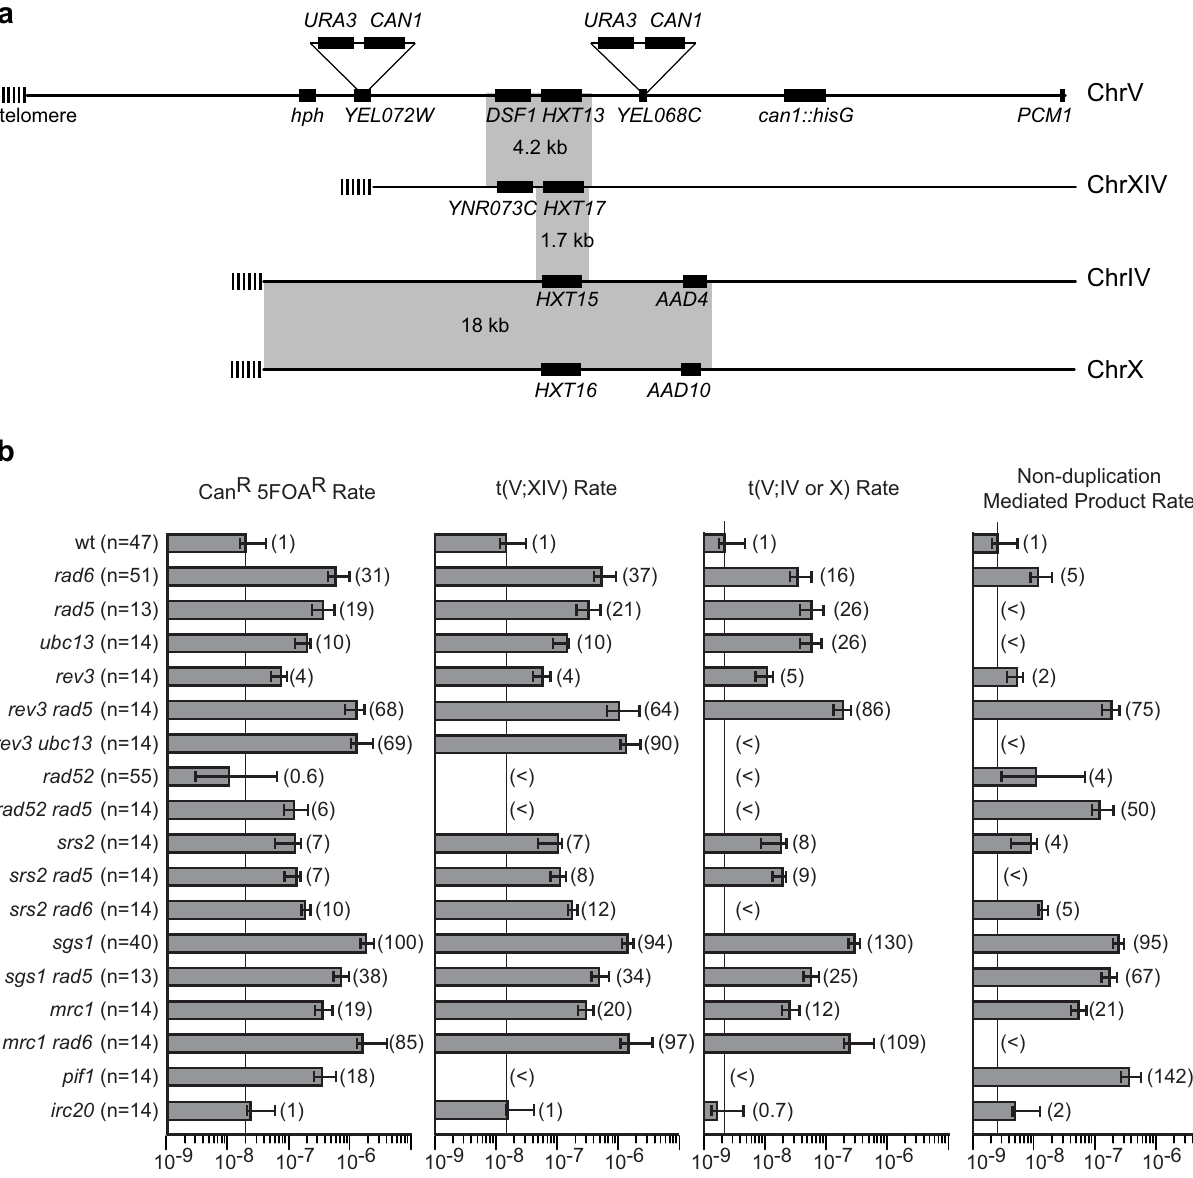
primarily due to the formation of homology-mediated rearrange- ments (Figure 1b). Unlike mrc1 D , however, rad6 D appeared to be epistatic to the mrc1-aq allele (p = 0.1), which is specifically defective in the MRC1 checkpoint function but not the replication function [30]. Similar to mrc1-aq , deletion of MEC1 or RAD53 , which encode protein kinases involved in the checkpoint response [31], appeared to be epistatic with rad6 D (p = 0.09 and p = 0.4, respectively). In contrast, deletion of RAD9 , which specifically